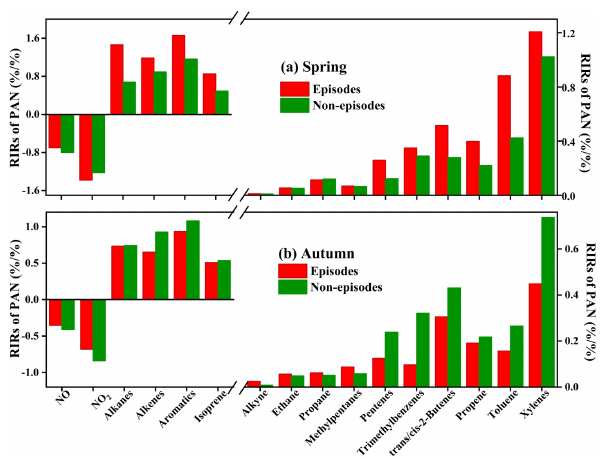
Figure 6. The OBM-MCM calculated relative incremental reac- tivity (RIR) for major PAN precursor groups and the top 10 spe- cific species in (a) spring and (b) autumn during the day (06:00– 17:00local